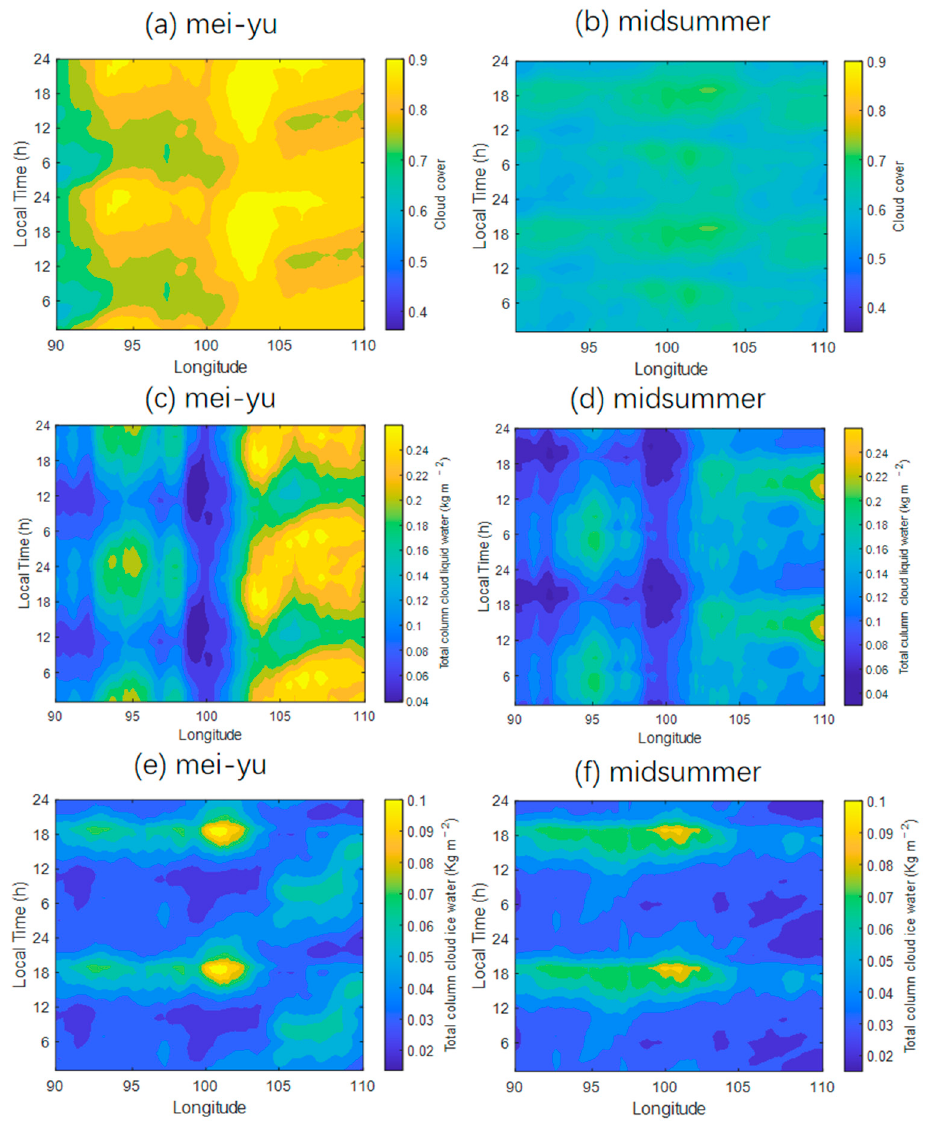
Figure 3. Diurnal variation in ( a , b ) cloud cover, ( c , d ) total column cloud liquid water content, and ( e , f ) cloud ice water content from ERA5 over the Tibetan Plateau and Sichuan Basin during the ( a , c , e ) mei-yu and ( b , d , f ) midsummer periods.